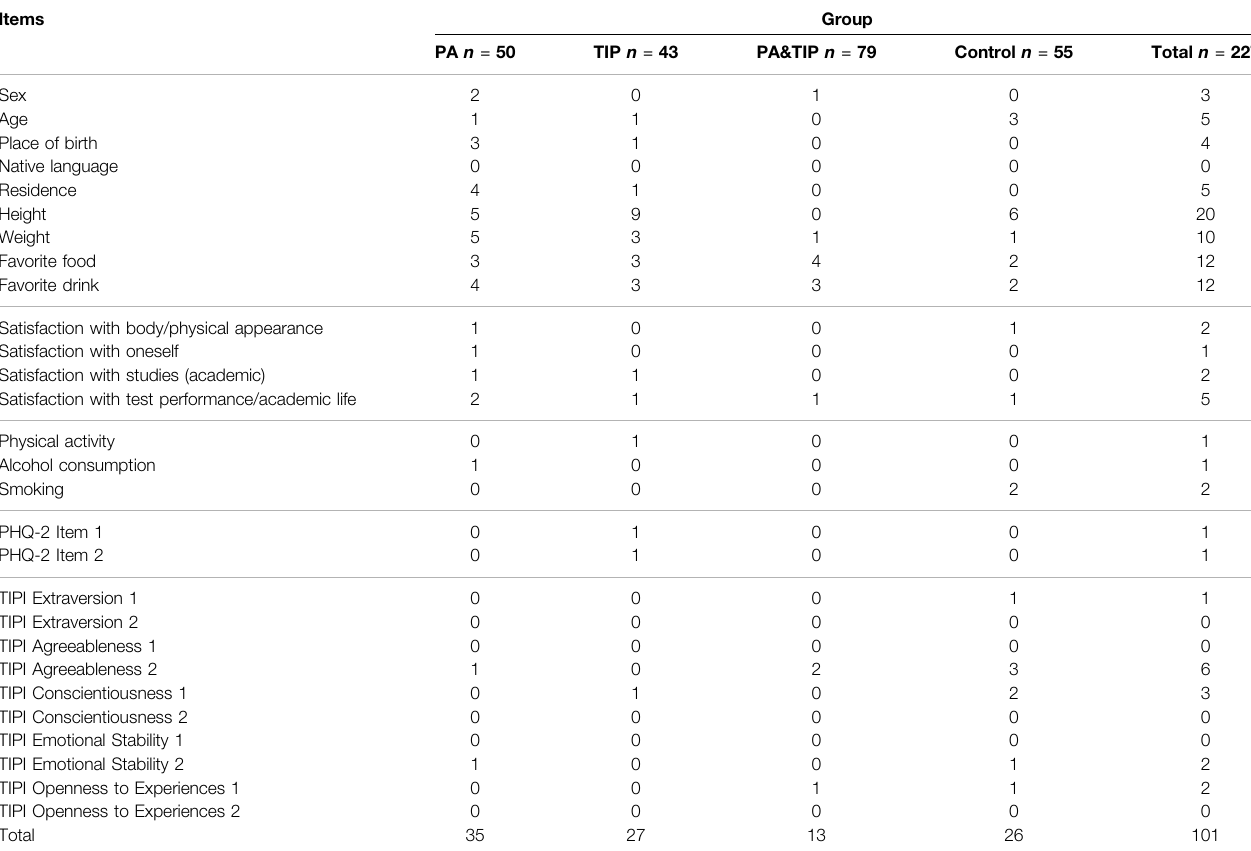
TABLE 3 | Number of “ no answer “ for the survey items asking for personal data for all participants (total) and across experimental groups.